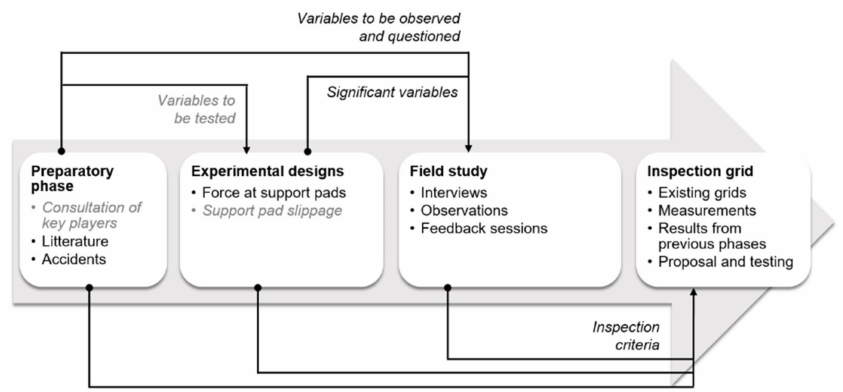
Figure 3. Overall methodology (parts discussed in this paper are in gray and